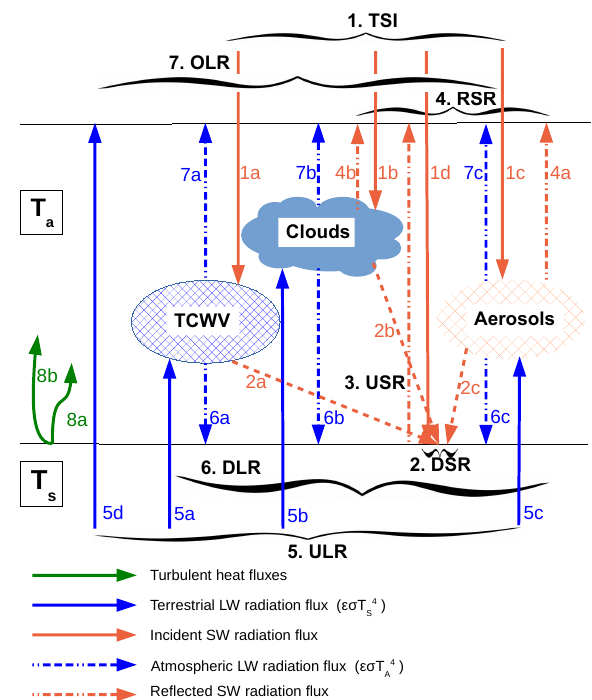
Figure 1. Simplified schematic of major processes controlling broadband radiation fluxes. Red arrows indicate shortwave radia- tion fluxes; blue arrows longwave radiation fluxes. For a detailed description of the arrows, please see Sect.